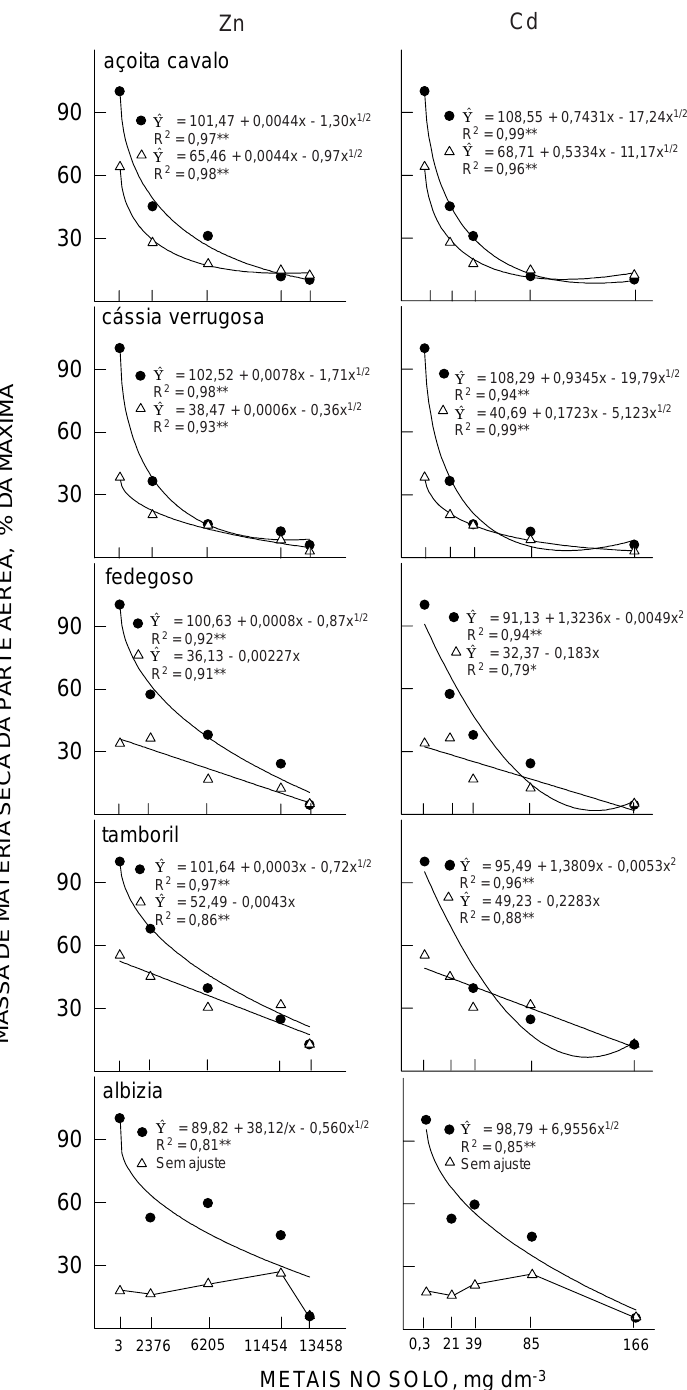
Figura 4. Relação entre massa de matéria seca relativa à máxima após 180 dias do transplantio e teores de Zn e Cd no solo no transplantio, para plantas inoculadas ( (cid:190) (cid:190)(cid:190) (cid:190)(cid:190) (cid:190)(cid:190) (cid:190)(cid:190) (cid:190) ), e sem inoculação ( (cid:190)D(cid:190)(cid:190)D(cid:190)(cid:190)D(cid:190)(cid:190)D(cid:190)(cid:190)D(cid:190) ) com fungos micorrízicos arbusculares.